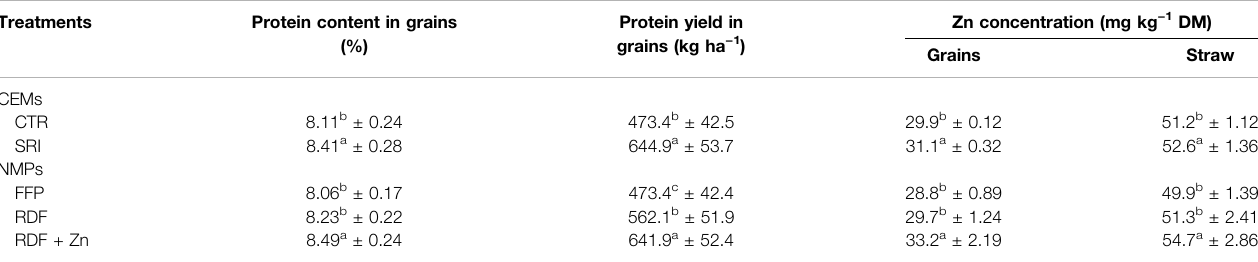
TABLE 5 | Effect of different CEMs and NMPs on the protein content in grains, protein yield, and Zn concentration in rice grains and straw (4 years av.). Treatments Protein content in grains